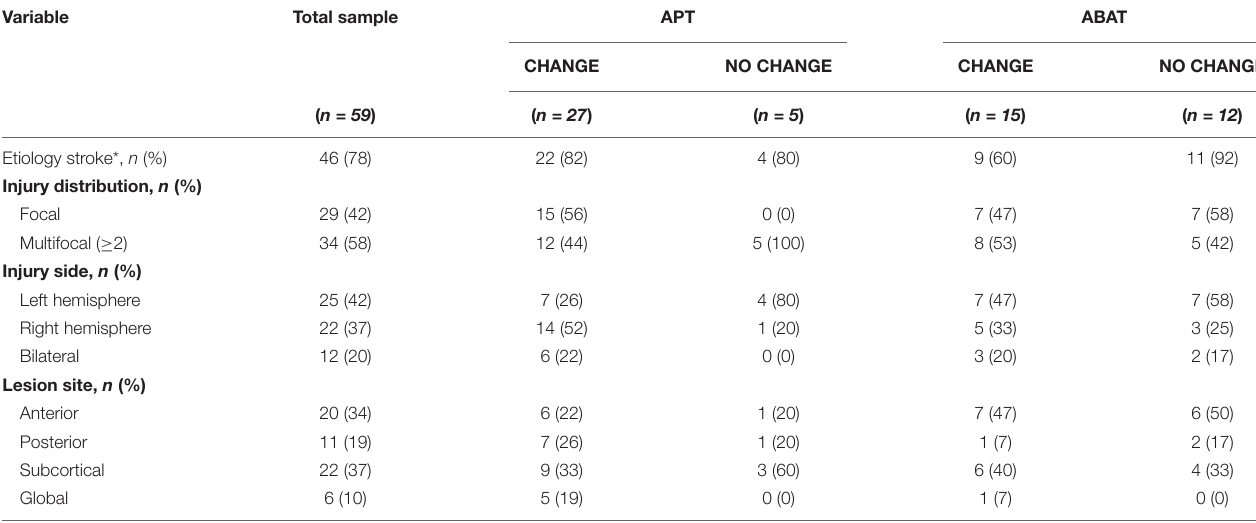
TABLE 2 | Injury related characteristics of participants at baseline assessment according to type of treatment and treatment outcome (CHANGE vs. NO CHANGE). Variable Total sample APT